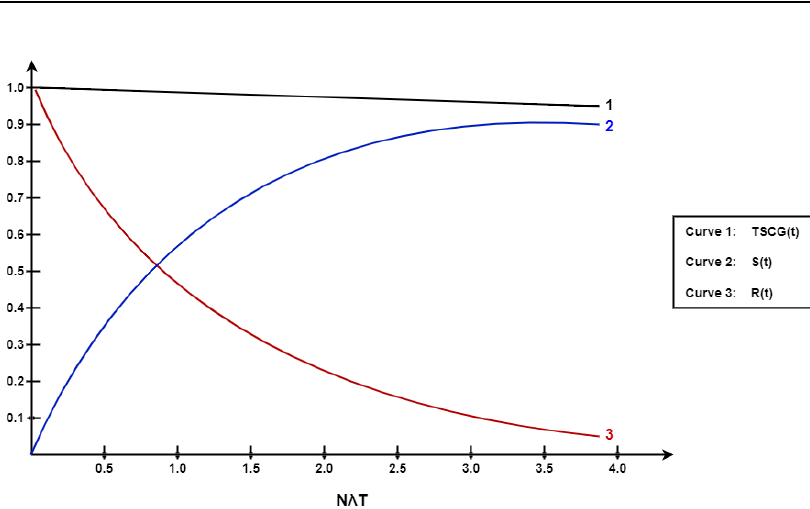
Figure 4. The calculation of TSCG ( t ) , S ( t ) and R ( t ) in time for the given